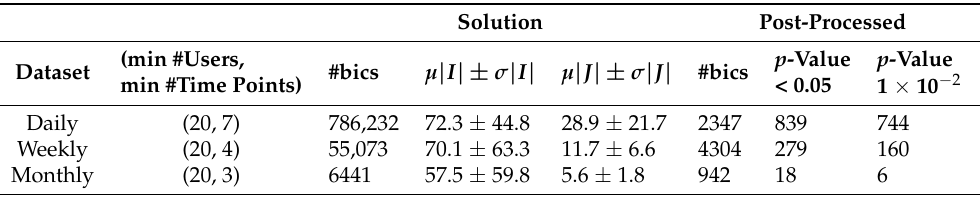
Table 4. Properties of e-CCC biclustering solutions with tolerance to noise under a constant pattern assumption at InfraQuinta, 2017.